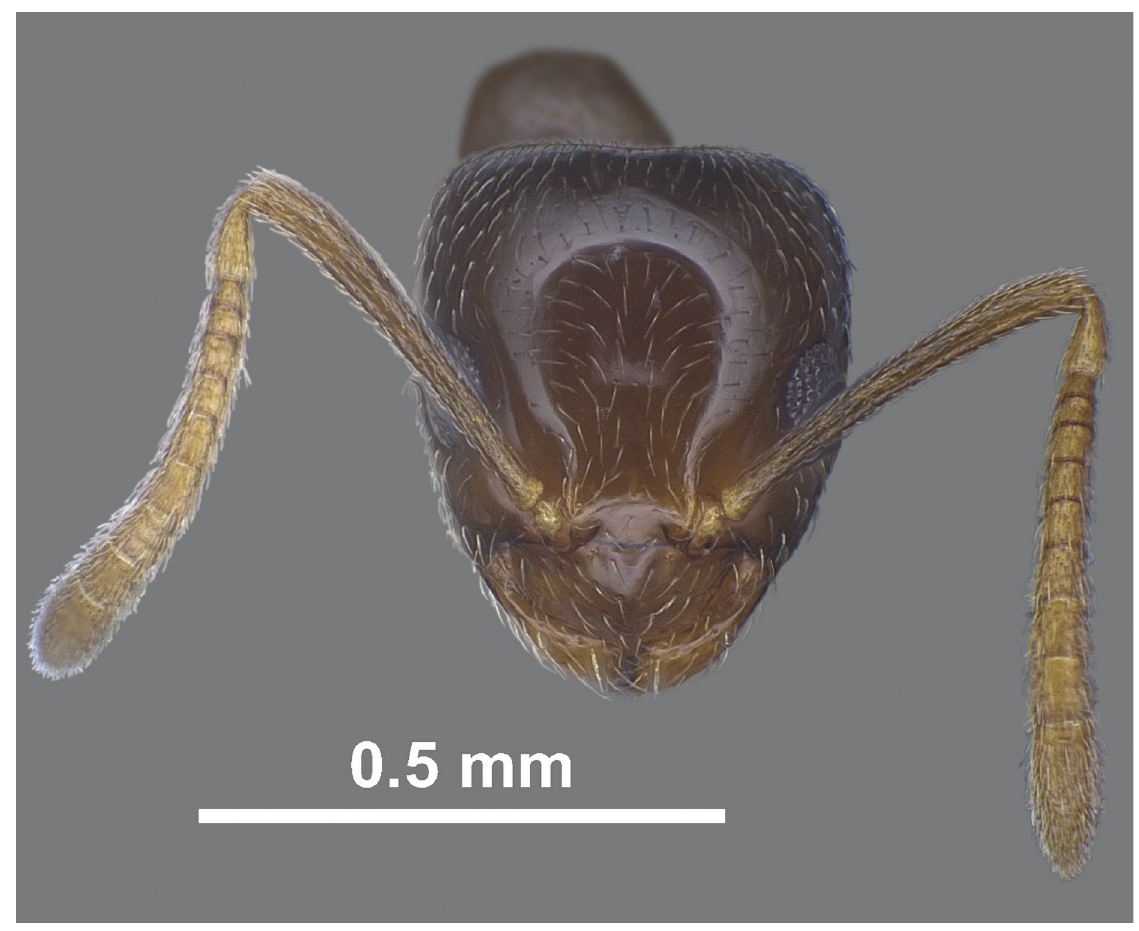
Figure 6. Head of the holotype worker of Plagiolepis invadens sp. nov.